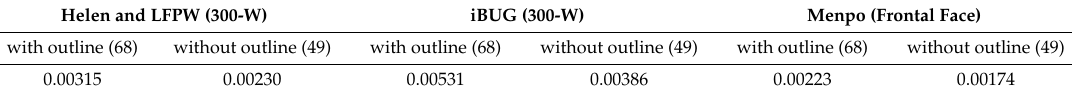
Table 1. The size normalized median landmark error of CE-CLM on 300-W and Menpo [40–42]. Helen and LFPW (300-W)